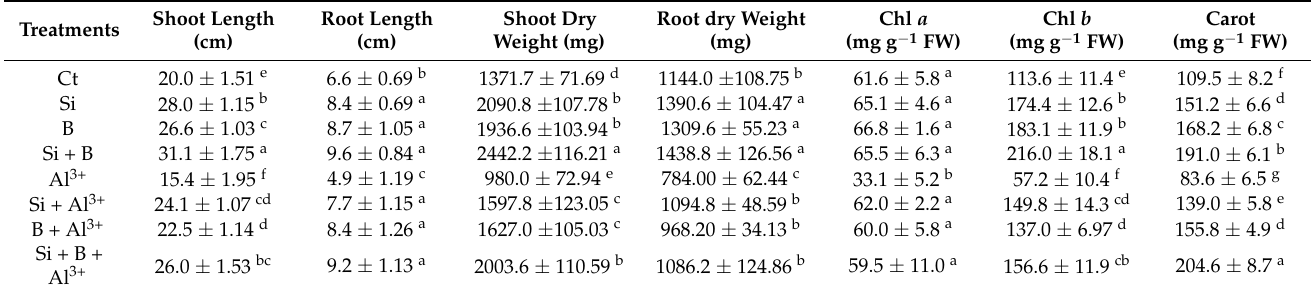
Table 1. The exogenous application of Si and B alone and in combination with date palm.